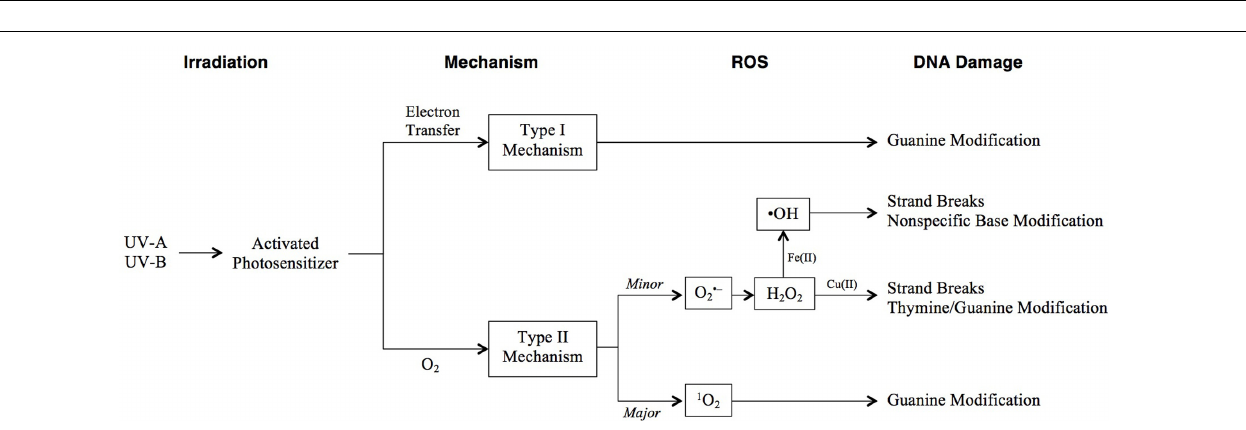
FIGURE 2 | Bipyrimidine lesions, the primary form of ultraviolet (UV)-induced DNA damage. Shown above are TT photolesions. Similar chemistry occurs at the other bipyrimidine sites, with the exception that 5 (cid:48) -CT-3 (cid:48) sequences only form CPDs (Sinha and Häder, 2002). Figure adapted from Rastogi et al. (2010).